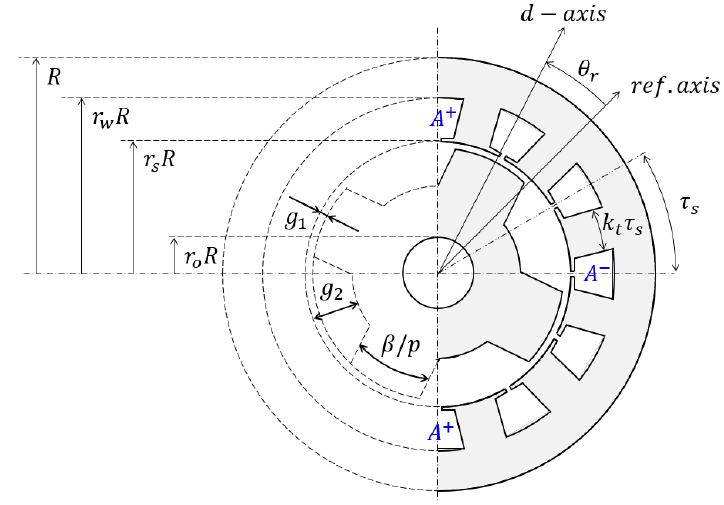
Figure 1. Design of the SynRM and main geometric parameters (with p = 2).